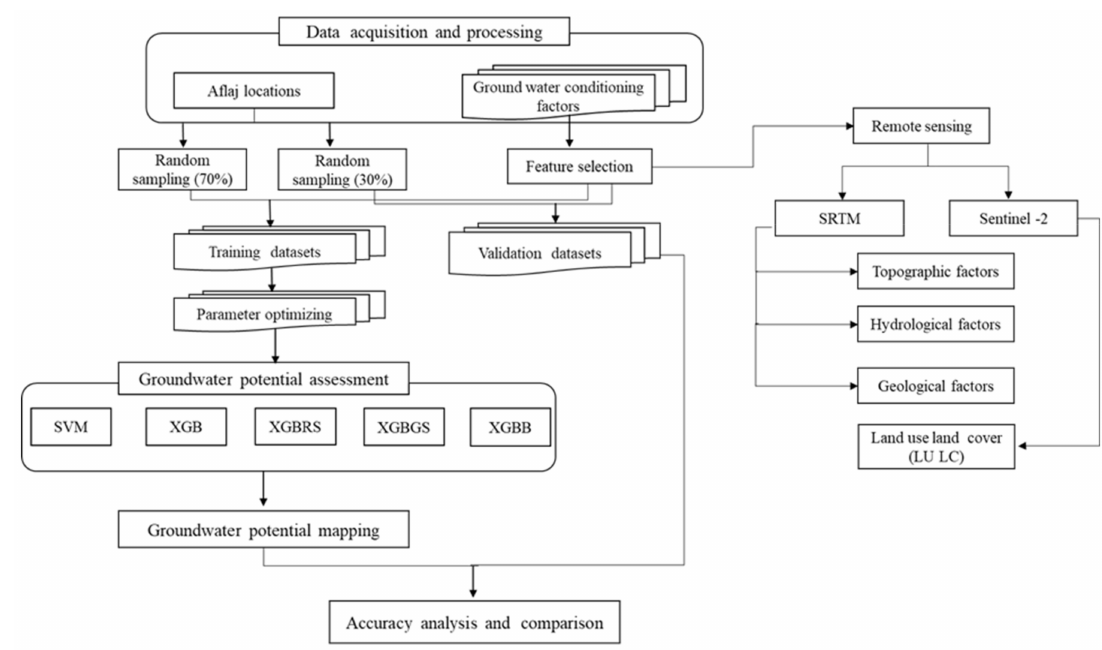
Figure 3. The flowchart illustrates the steps of data analyses in the study